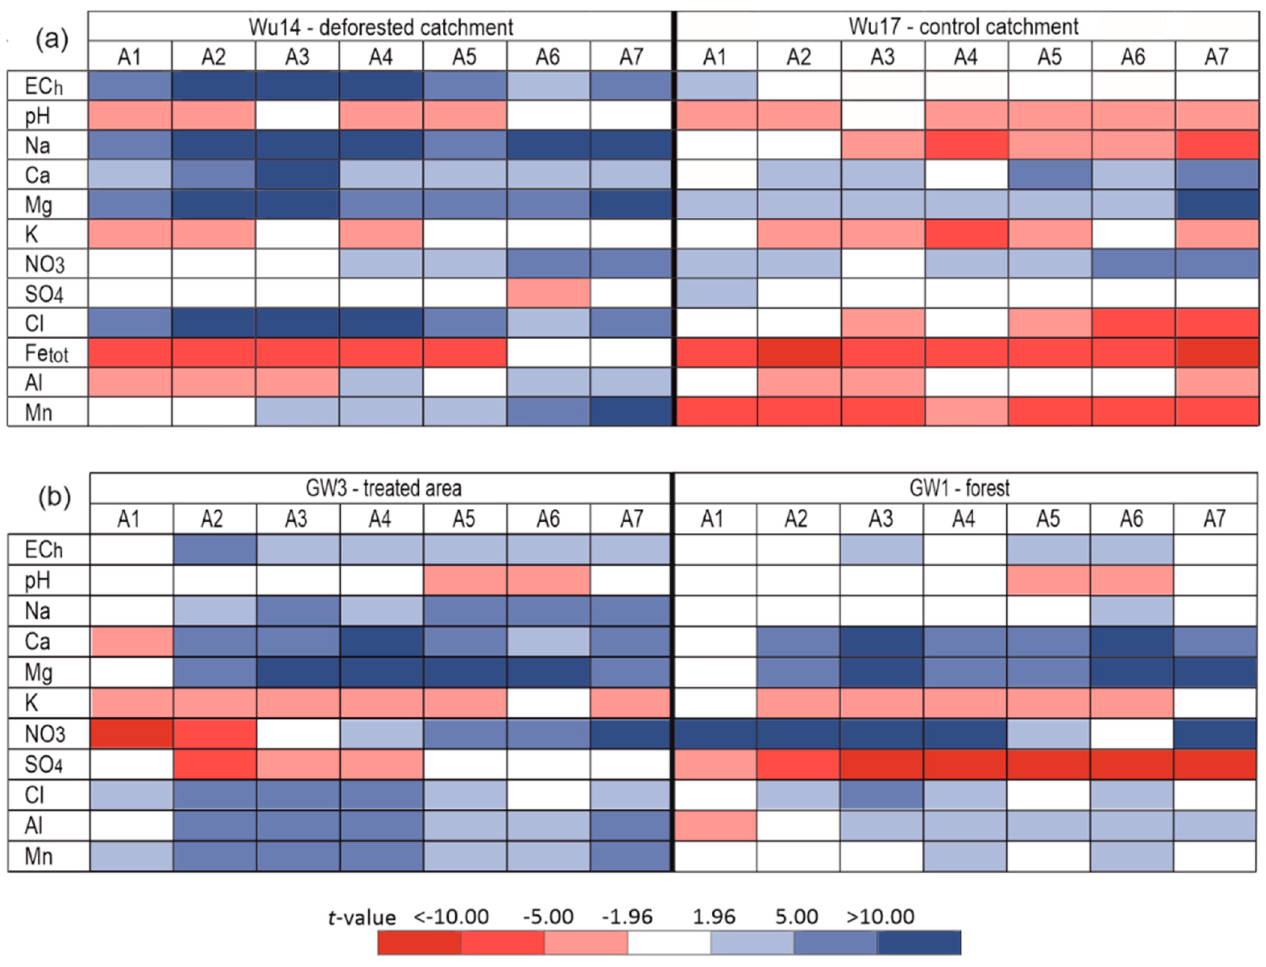
Figure 6. Significant (colored) differences between the pre-deforestation period (Sep 2011–Aug 2013) and each year after deforestation (A1–A7) for ( a ) stream water and ( b ) groundwater. Average daily values for pH and concentration of ions were analyzed; EC h —water electric conductivity was measured at the time of sampling. Light, medium, and dark blue colors indicate small, medium, and large decreases, respectively ( t > 1.96), and light, medium, and dark red colors indicate small, medium, and large increases, respectively ( t < − 1.96).